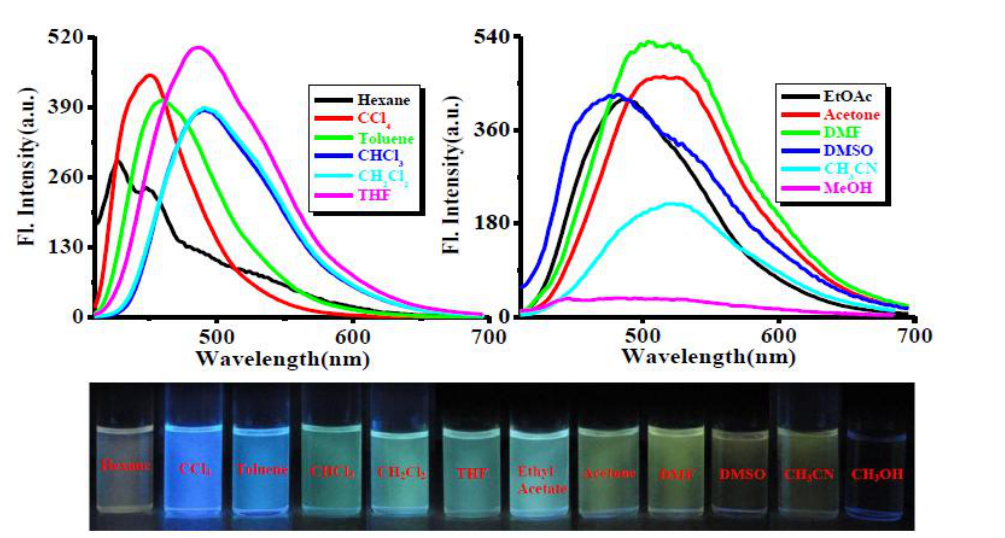
Figure 19: Comparative fluorescence of compound 29 in different solvents at 1x 10 -5 M (up) and their naked-eye flurescence change under hand held UV lamp (down).(adapted from ref. 57).